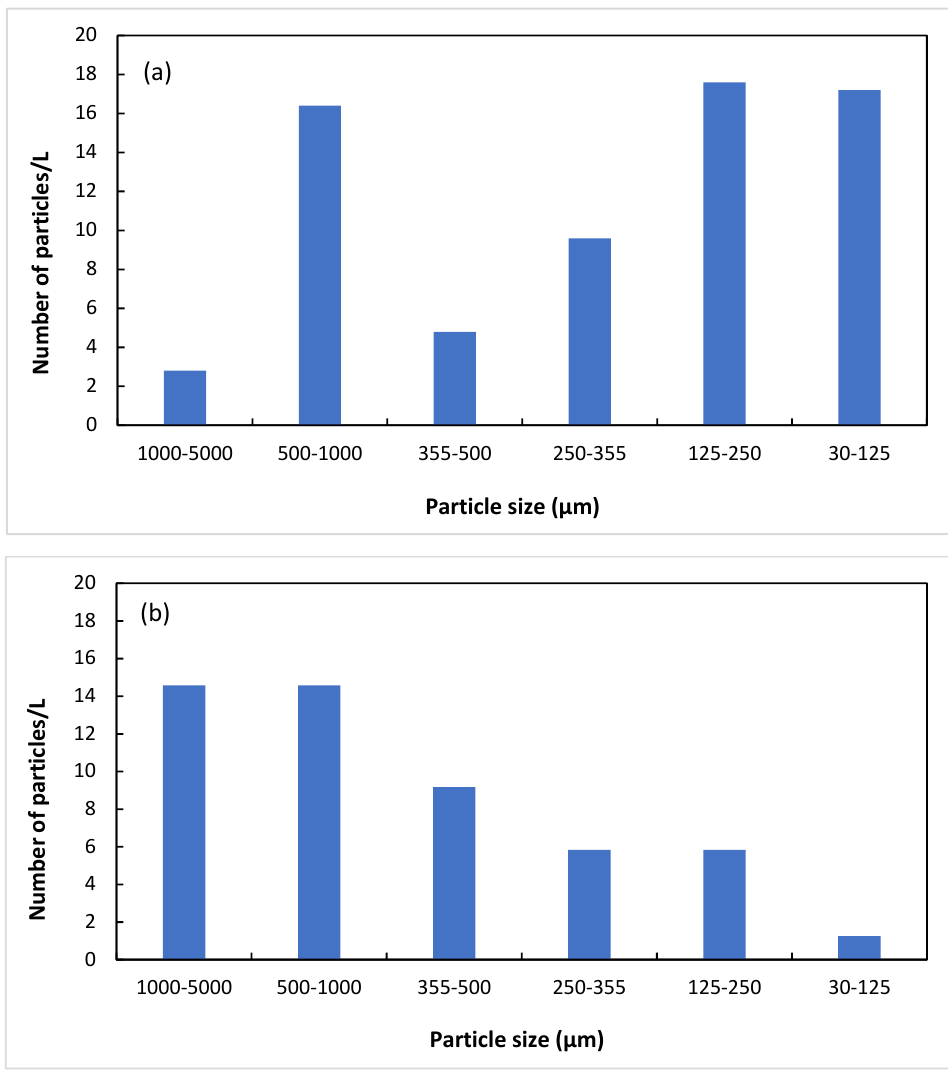
Figure 2. Concentration of microplastics in samples from plastics recycling facility: ( a ) untreated and ( b ) treated .